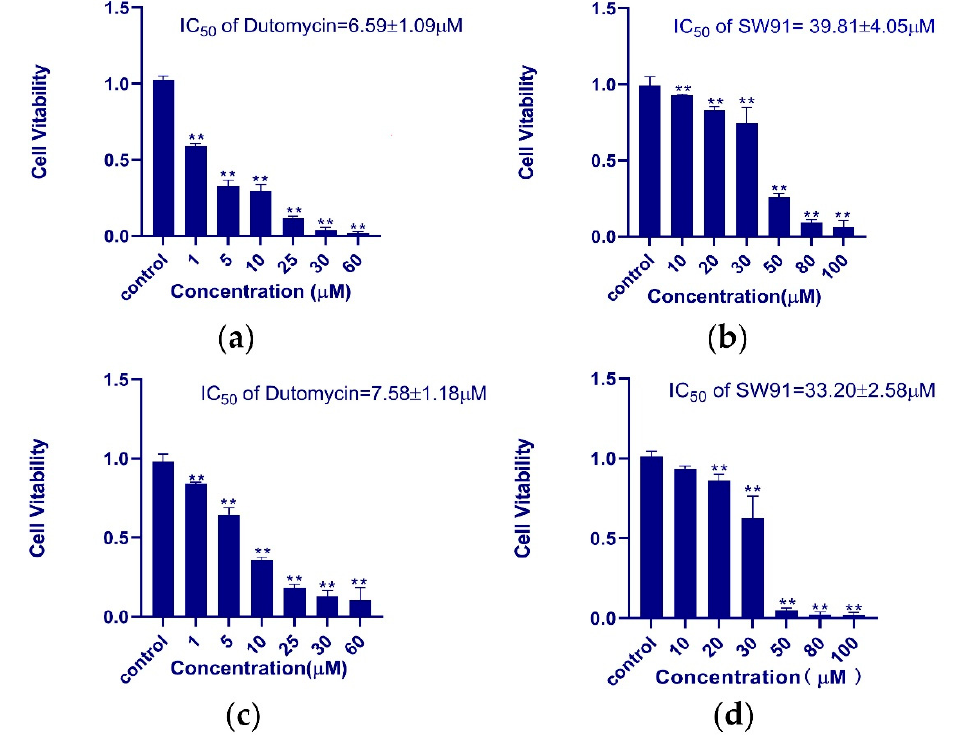
Figure 2. The histogram of the survival rate of dutomycin and SW91 in different cell lines: ( a ) cell survival rate in cancer cell HepG2 at different concentrations of dutomycin ( µ M); ( b ) cell survival rate under different concentrations of SW91 ( µ M) in cancer cell HepG2; ( c ) cell survival rate at different concentrations of dutomycin ( µ M) in cancer cell Smmc-7721; ( d ) cell survival rate at different concentrations of SW91 ( µ M) in cancer cell Smmc-7721. p -Values were considered significant compared to the control if they were less than 0.05, and they are indicated throughout using asterisks: ** p < 0.01.